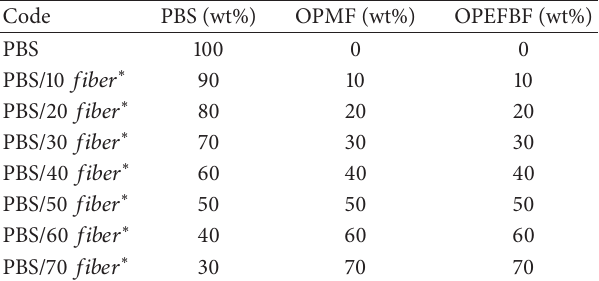
Table 2: Formulations of PBS